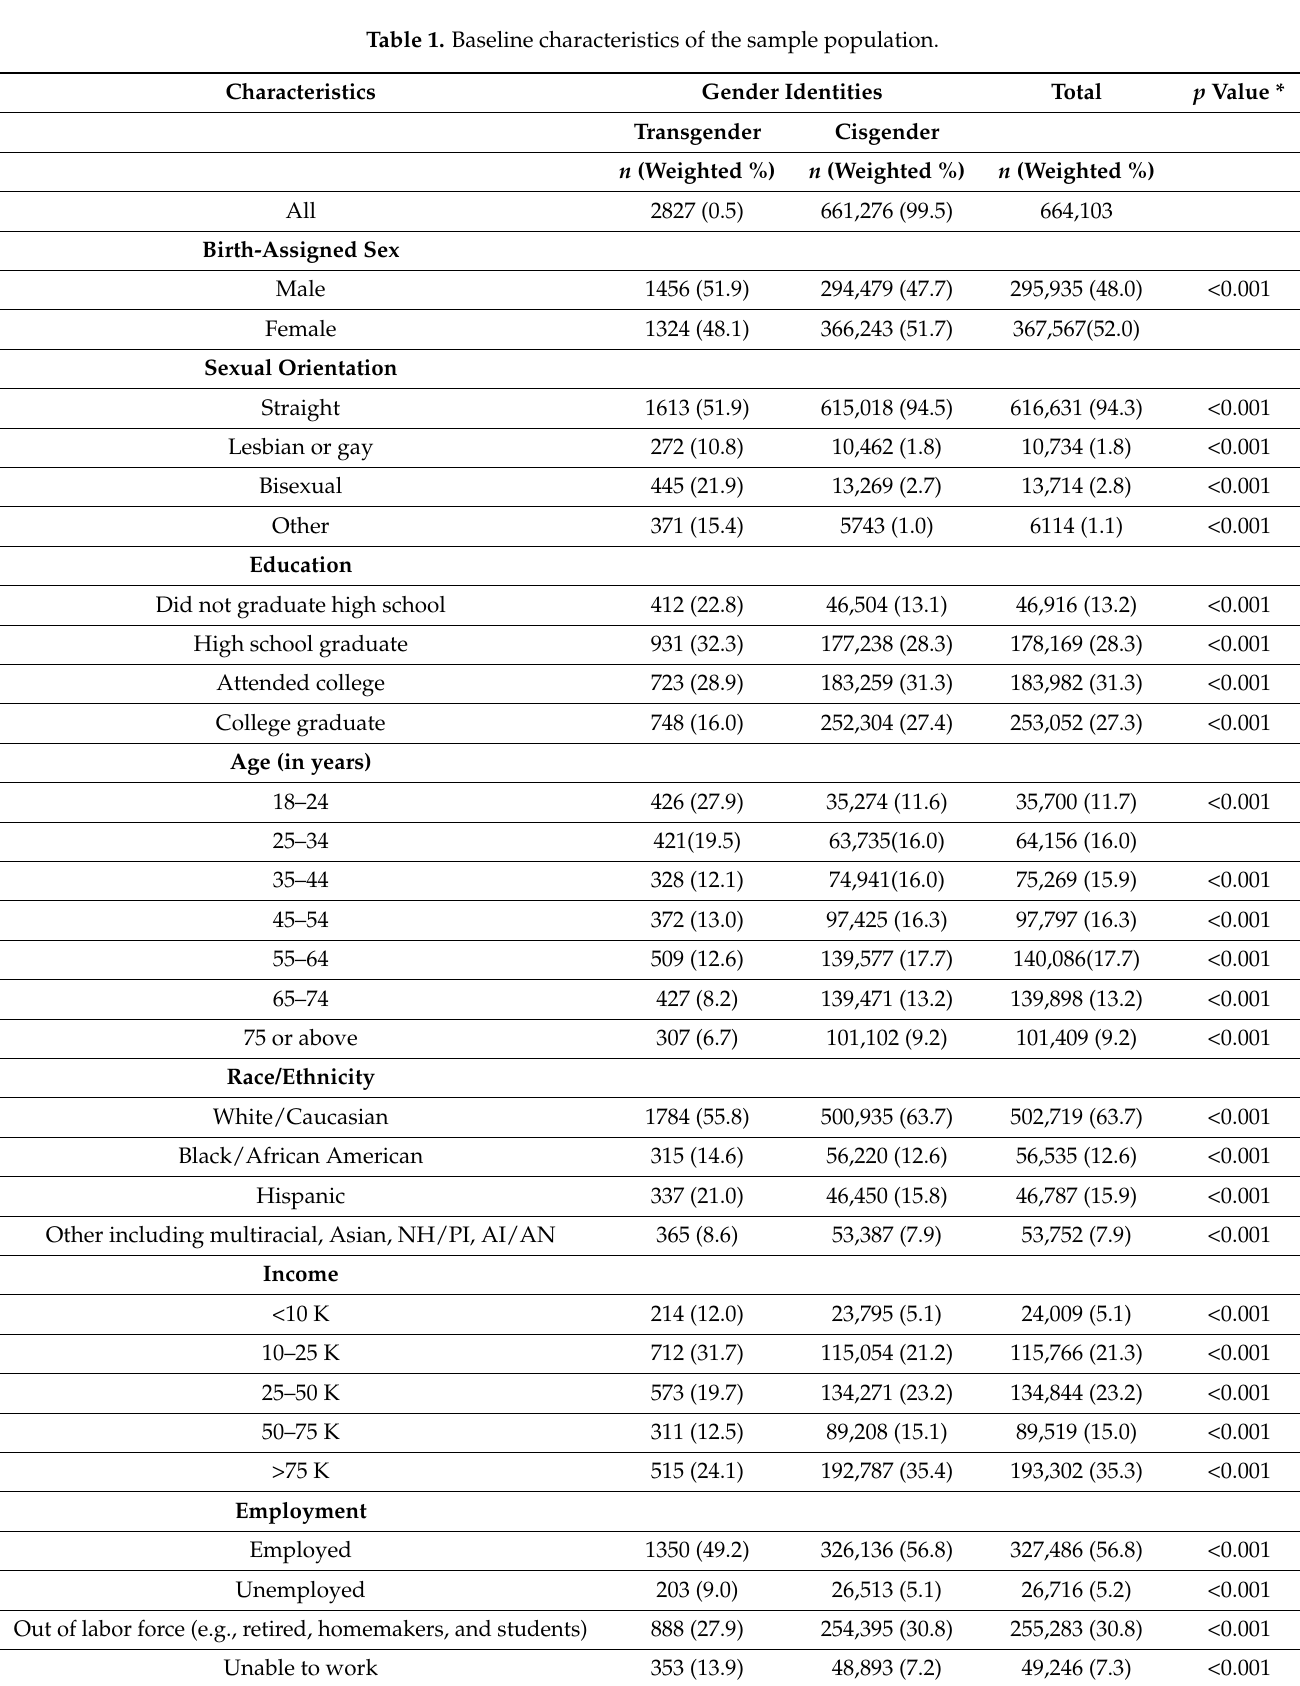
Table 1. Baseline characteristics of the sample